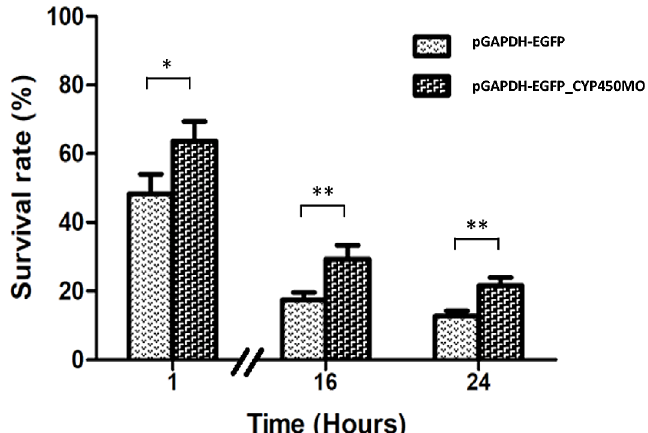
Figure 4. Survival rate of Acanthamoeba treated with PHMB. Survival rate of Acanthamoeba cells transfected with pGAPDH-EGFP and pGAPDH-EGFP-CYP450MO vector incubated with 0.01% PHMB for 1, 16, and 24 h. Data are presented as mean ± standard deviation